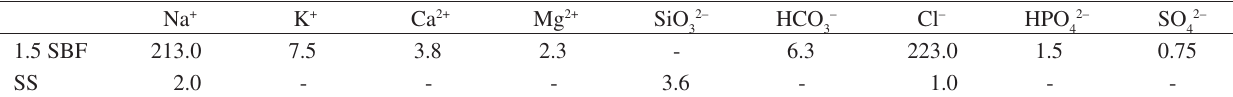
Table 1. Ionic content of the used solutions (mmol.dm –3 ).